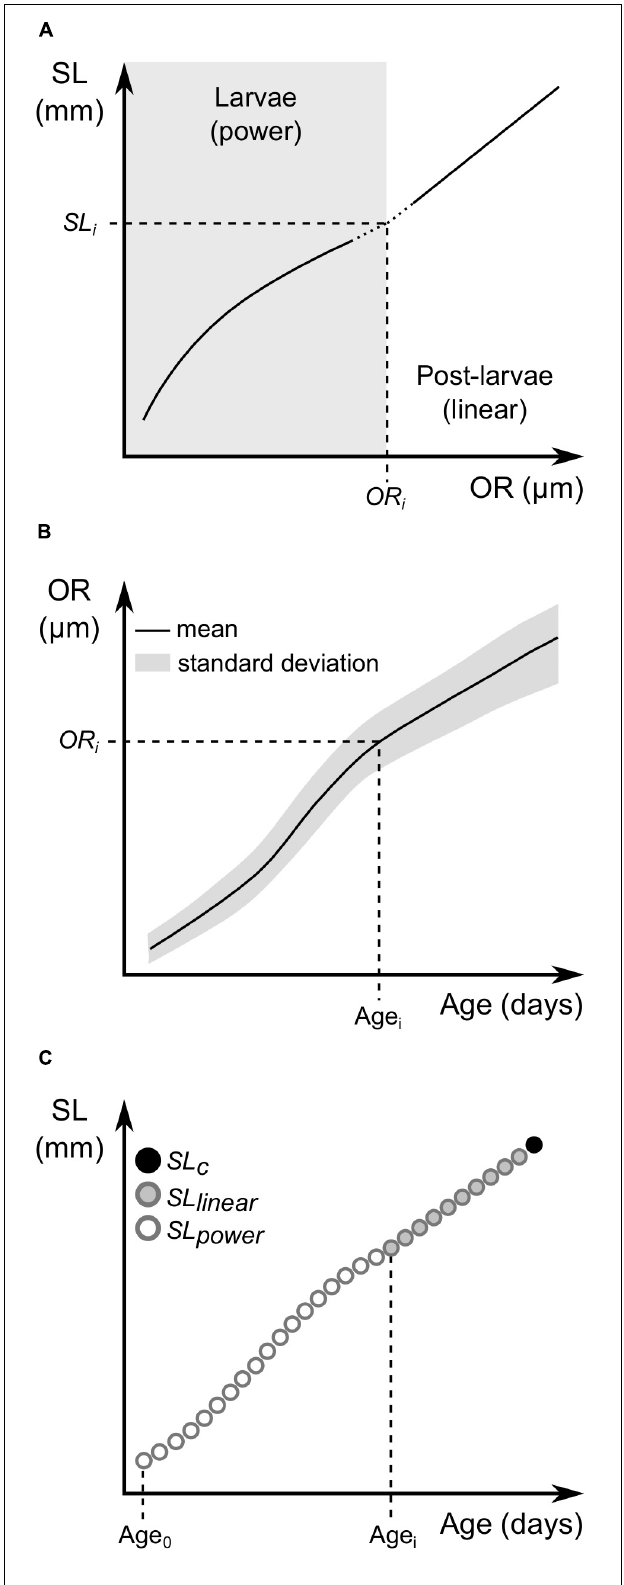
FIGURE 2 | Schematic illustration of post-larval daily growth back-calculations. (A) General models were fitted to otolith radius (OR) and standard length (SL) relations according to developmental stage: a power relation for larvae (gray panel) and a linear function for post-larvae. The interception between both models was estimated at OR i and SL i . (B) The mean age at which OR i is attained (Age i ) was interpolated. (C) SL back-calculations were performed from capture ( SL c ) to Age i applying a linear model ( SL linear ) and from Age i to the first feeding day (Age 0 ) with a power model ( SL power ). SL of both stages from each specimen were concatenated and daily growth rates were estimated as the difference in SL between consecutive